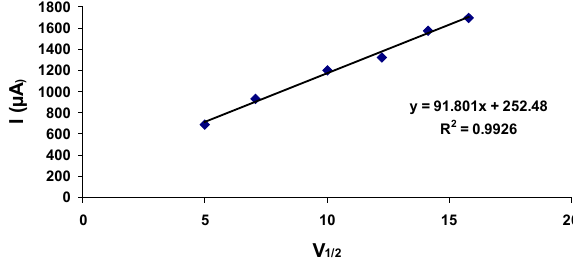
Figure 4: Illustration of the dependence of the current intensity on the square root of the potential sweep rate, studied between 25